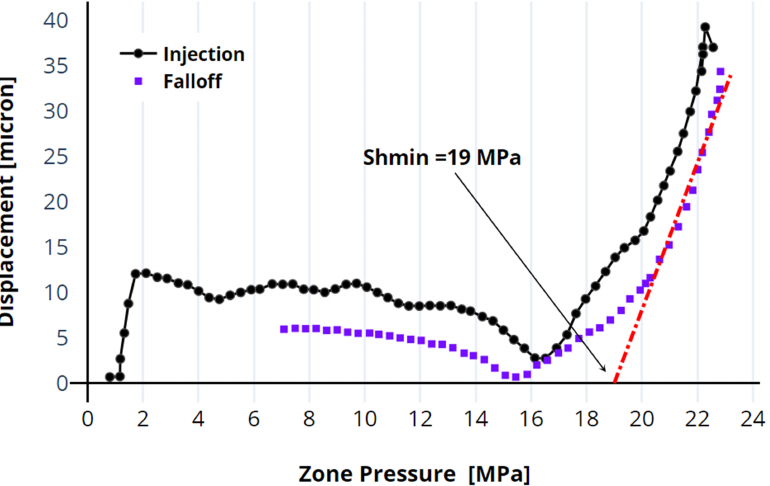
Figure 16. SIMFIP displacement versus zone pressure for cycle 2.2 (modified from [42]).